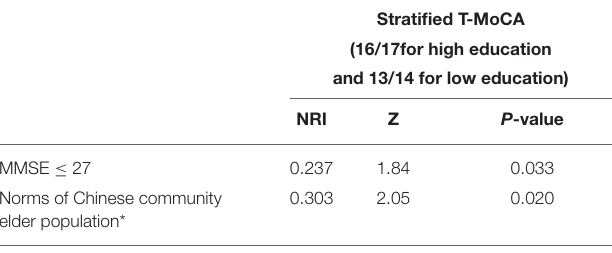
TABLE 3 | Net reclassification index for T-MoCA by MMSE criteria for